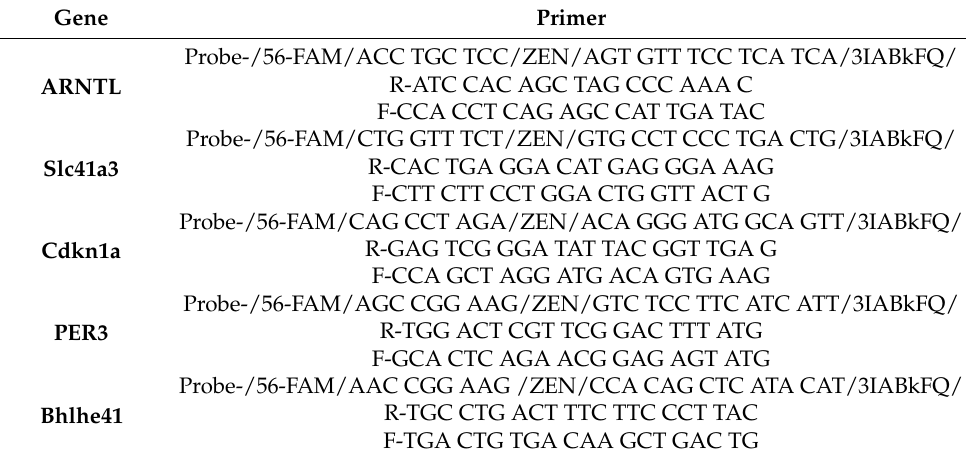
Table 2. Quantitative RT-PCR primers used in this study.